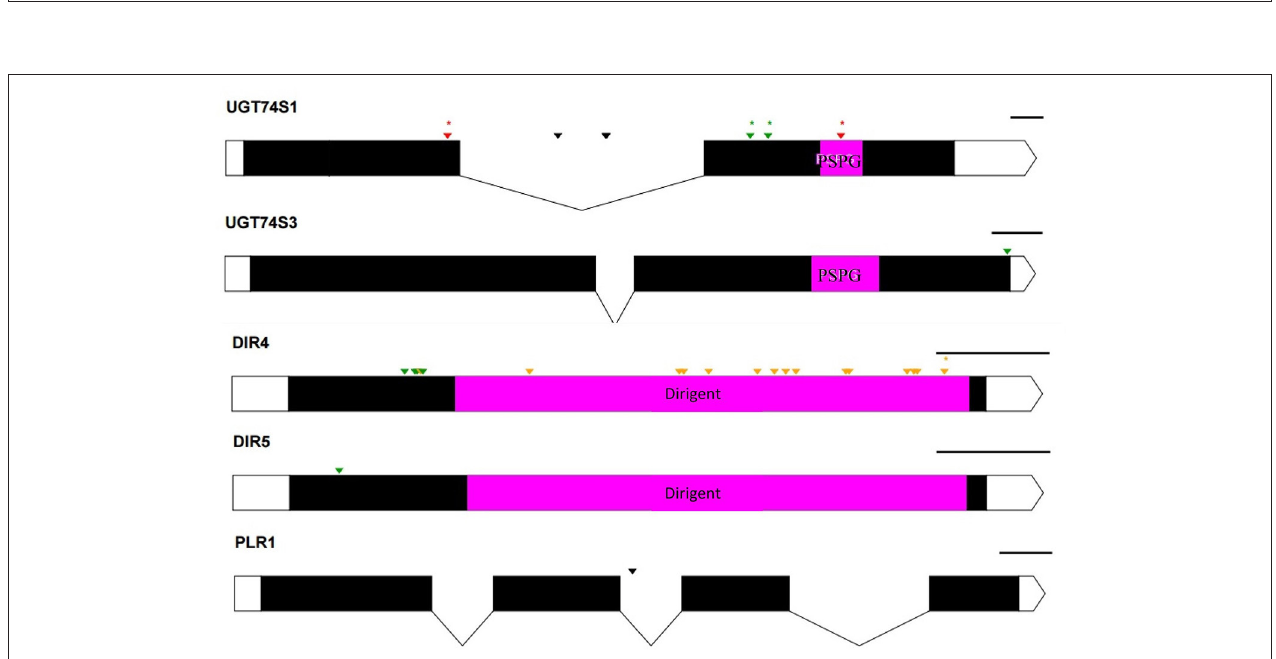
FIGURE 6 | Distribution of EMS-induced mutations on five genes of the 11 custom gene panel submitted to Ampliseq sequencing. UTRs are indicated by white boxes, exons by solid black boxes, and introns by gaps with downward arrows. The PSPG region within exon 2 of UGT74S1 and UGT74S3 is colored in magenta. The magenta box in DIR genes indicates DIR protein domains. The PSPG and dirigent regions are conserved domains for UGT and dirigent proteins, respectively. Green arrows, missense mutations; orange arrows, sense mutations; red arrows, nonsense mutation; black arrows, mutations in introns; asterisks (*) indicate position of homozygous mutations only; The black lines on the right top of each gene indicate the gene drawing scale.